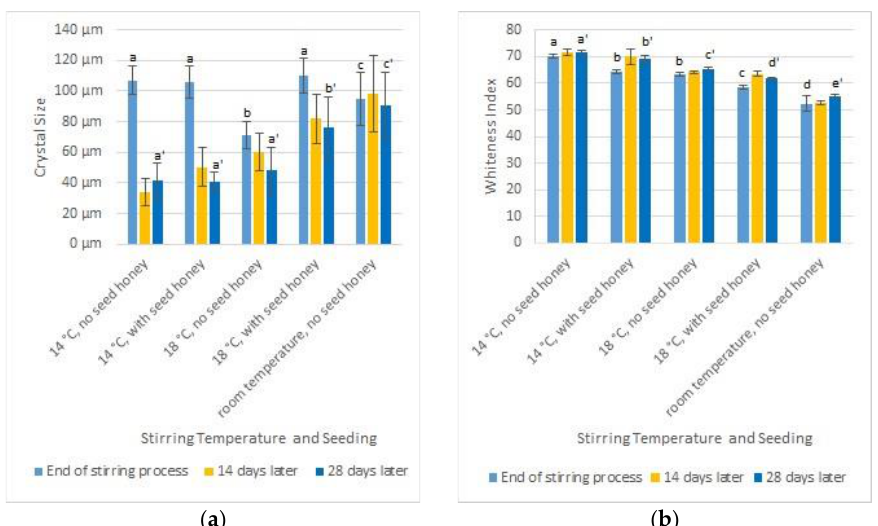
Figure 3. Influence of the stirring temperature and the addition of seed honey on the creaminess of honey. (a, b, c, d, a’, b’, c’, d’, e’ denote groups of significantly different samples.) ( a ) Mean and standard deviation of the size of the 10 largest crystals on different days. ( b ) Mean and standard deviation of whiteness index of the honey on different days. deviation of whiteness index of the honey on different days.